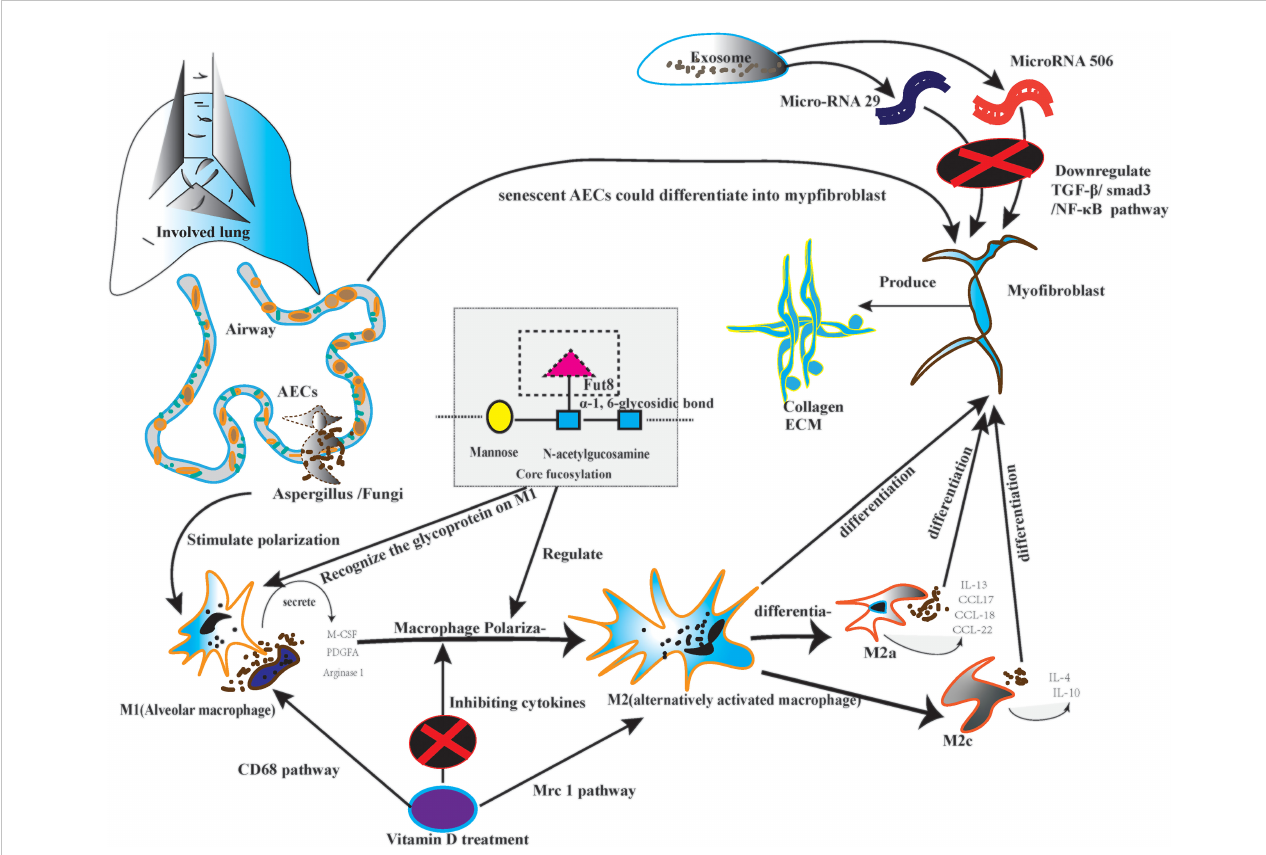
FIGURE 2 The picture depicted the core fucosylation regulating macrophage polarization on lung fi brosis